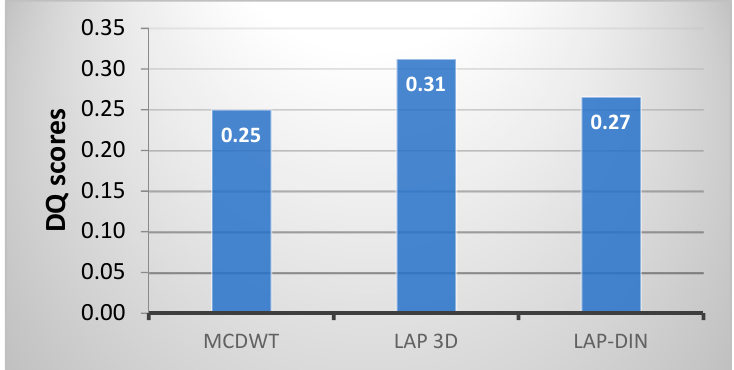
Figure 15. Results of objective measure DQ on three video fusion methods on database set. Table 2. Results of objective measure DQ on dataset sequences separately.